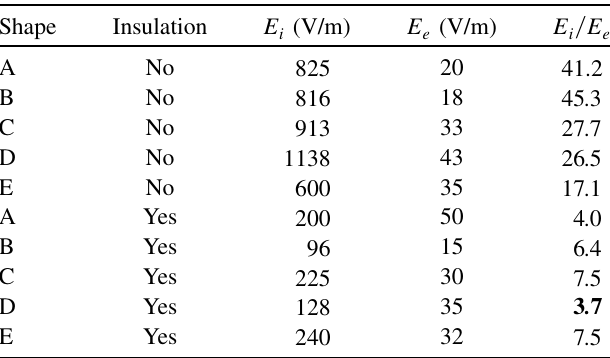
TABLE I. Electric field at the iris and at the equator of the ILC cavity for different cathode configurations. Shape